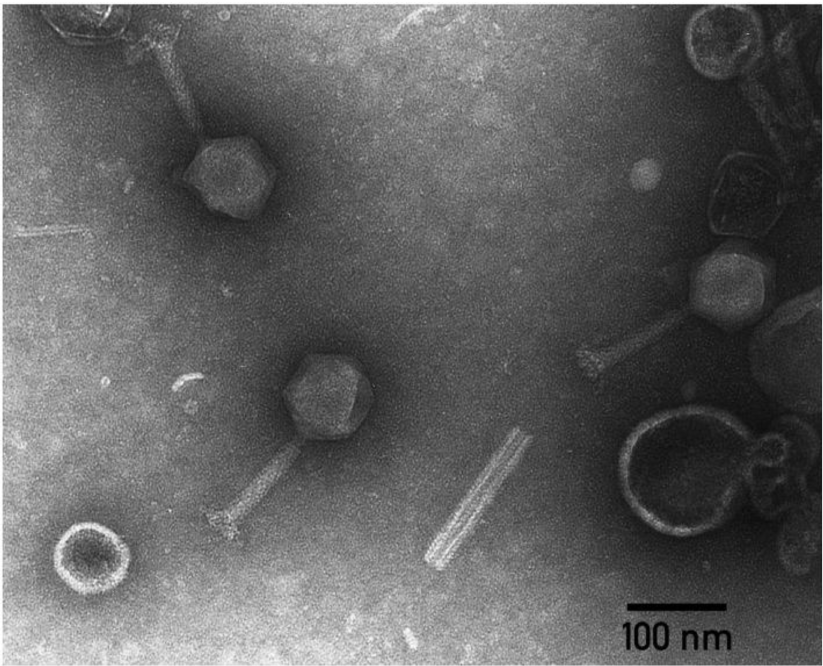
Figure 4. Transmission electron microscopy of Ackermannviridae Dickeya phage PP35 [80]. The scalebar is 100 nm. The image was kindly provided by Dr. Ekarterina